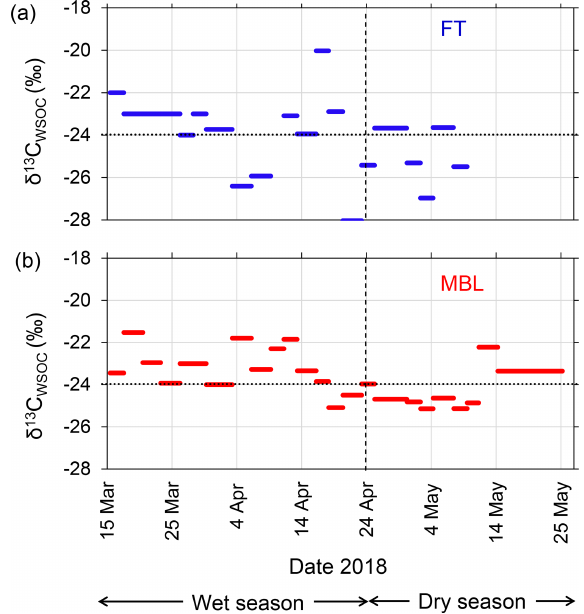
Figure 5. Time series of stable carbon isotope ratio of WSOC ( δ 13 C WSOC ) under (a) FT and (b) MBL conditions during the en- tire sampling period. Dashed lines indicate the transition from wet to dry seasons. Dotted lines indicate the boundary of δ 13 C WSOC ranges distinguishing assumed marine ( > − 24‰) and terrestrial sources ( < −